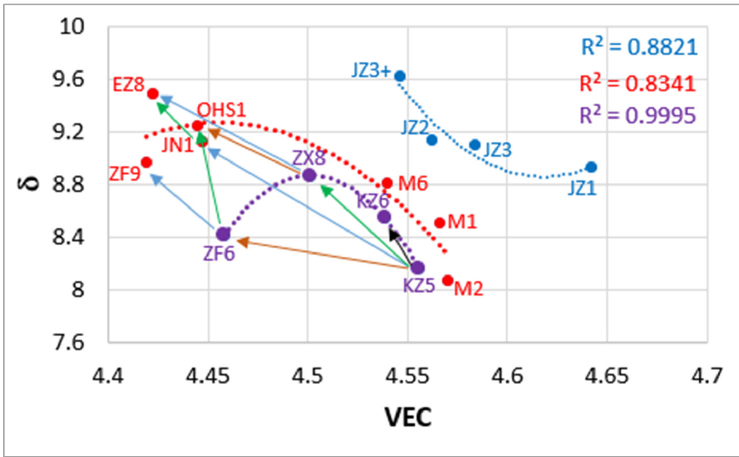
Figure 15. δ versus VEC map of Nb-silicide-based alloys with addition of Al, Cr, Ge, Hf, Sn, Ta, W. Arrows indicate addition of Hf (blue), Ta (black), Sn (green), Ge (brown). R 2 values for parabolic fit of data. Purple and red data for Ti rich alloys with KZ5 as the “basis” alloy, blue data for JZ series alloys. Nominal compositions (at.%) KZ5 = Nb-24Ti-18Si-5Al-5Cr, KZ6 = KZ5+6Ta, ZX8 = KZ5+5Sn, ZF6 = KZ5+5Ge, JN1 = KZ5+5Hf, ZF9 = KZ6+5Hf, EZ8 = JN1+5Sn, OHS1 = KZ5+5Ge+5Sn [10,13,35,36,38,47], see Appendix A. Actual compositions (at.%) M1 = Nb-24.8Ti-17.6Si-0.2Ge-5.3Cr- 2Hf-1.9Al-0.3Sn, M2 = Nb-26Ti-12.6Si-4.9Ge-6.7Cr-1.9Hf-1.9Al-0.5Sn, M3 = Nb-24.76Ti-16.8Si-4.2Ge-